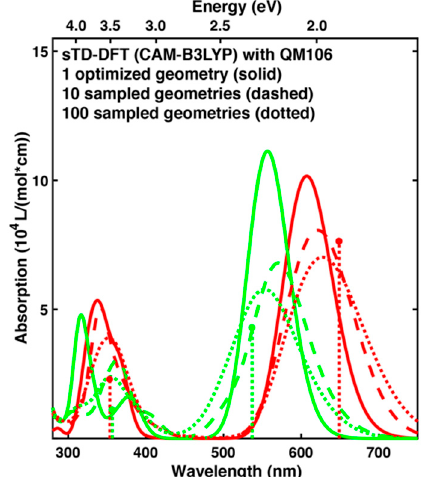
Figure 4. Absorption spectra for the P r (red) and P g (green) forms calculated with sTD-DFT for QM106. The spectra are either based on one singly optimized structure (solid), 10 snapshots from a QM / MM MD trajectory taken every 100 ps (dashed) or 100 snapshots taken every 10 ps from the same trajectory (dotted). The sticks represent the positions and relative intensities of the two lowest energy absorption maxima from experiment [14].